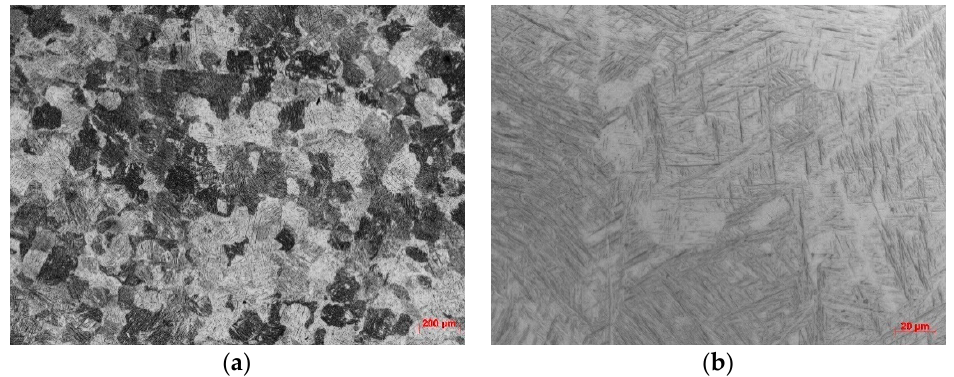
Figure 3. Microstructure of 3D-printed specimen: ( a ) 50 × ; ( b ) 500 × .